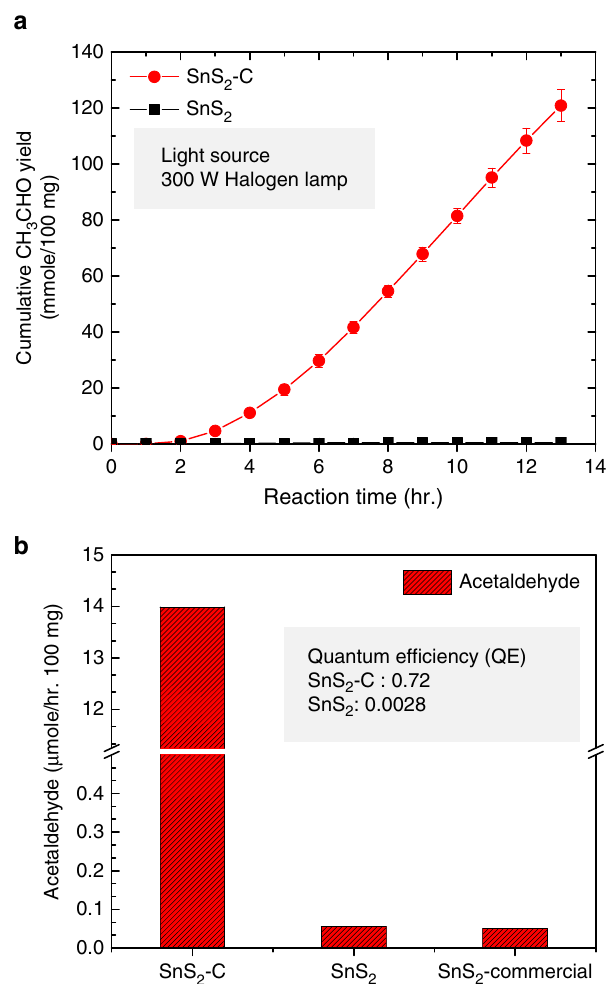
Fig. 5 Comparative photocatalytic CO 2 reduction activity of SnS 2 -C and SnS 2 . a Cumulative acetaldehyde formation yield of SnS 2 -C and SnS 2 . b Comparative solar fuel formation rate and quantum ef fi ciency of SnS 2 -C, SnS 2 , and commercial SnS 2 under a visible light source (300 W